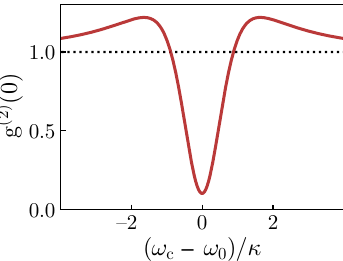
FIG. 9. Second-order optical correlation function g ( 2 ) ( 0 ) of a driven emitter-cavity system as a function of the cavity-emitter detuning ω c − ω 0 . Parameters: γ = 0.1 κ , η = 5 × 10 − 3 κ , g = 0.3 κ